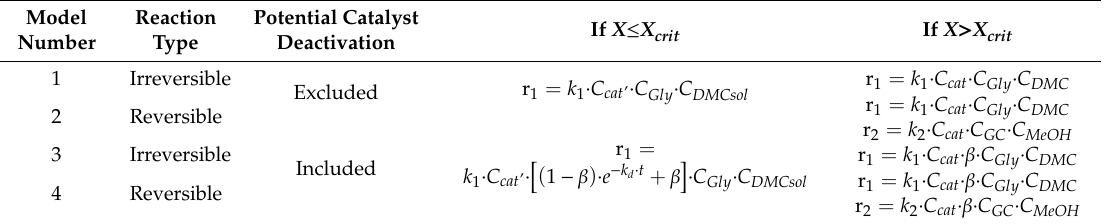
Table 6. Kinetic models for the transesterification of glycerol with dimethyl